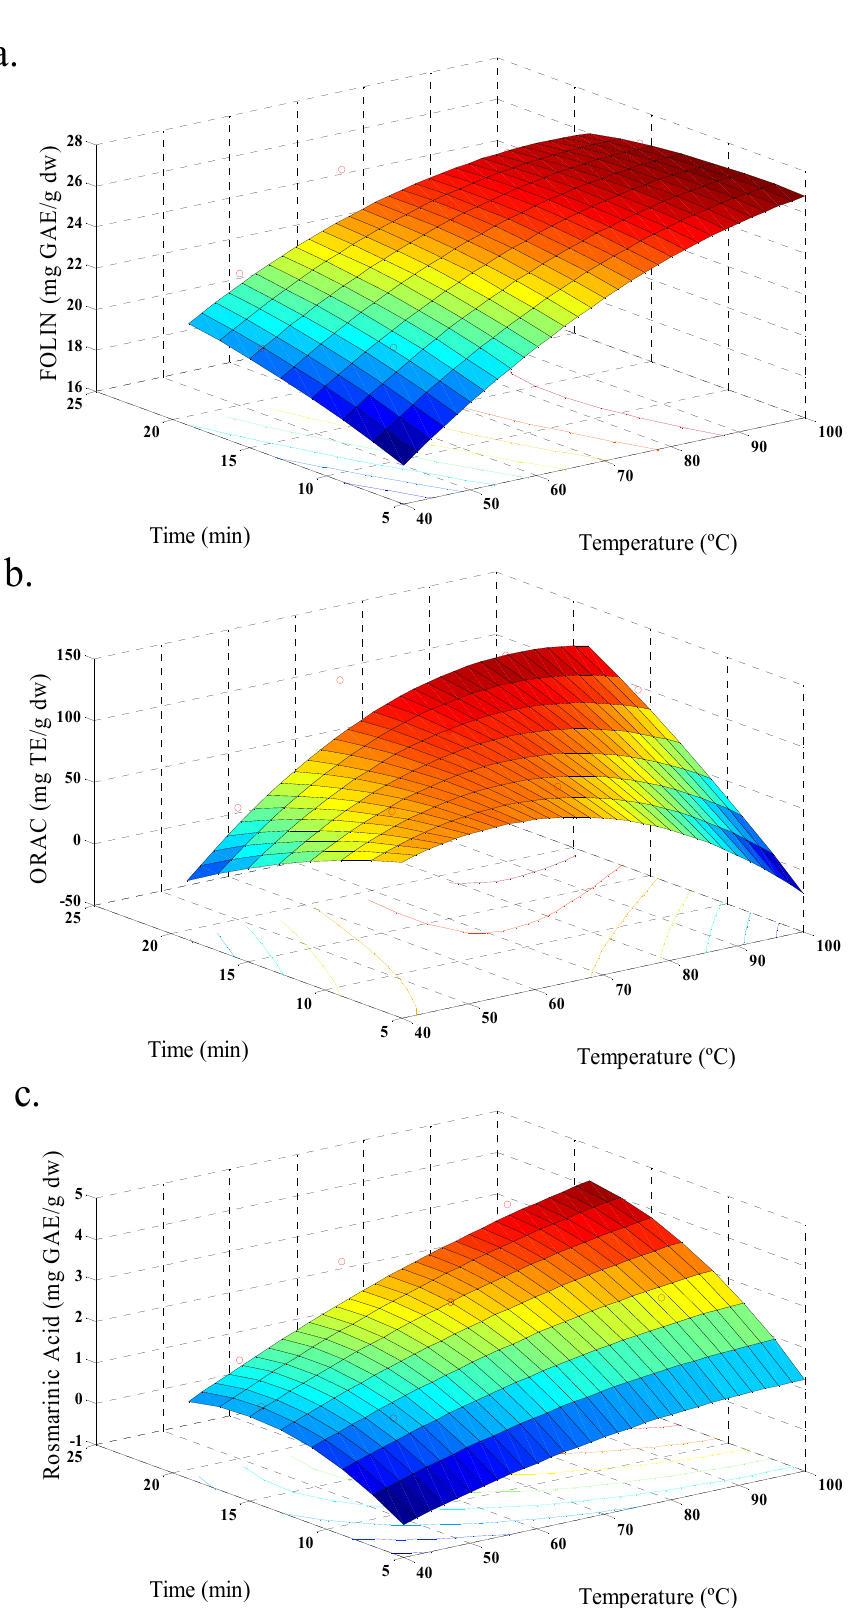
Figure 1. Response surface model plot, for aqueous extraction, showing the effects of time and temperature in: ( a ) total polyphenols contents; ( b ) antioxidant activity (ORAC); and ( c ) rosmarinic acid